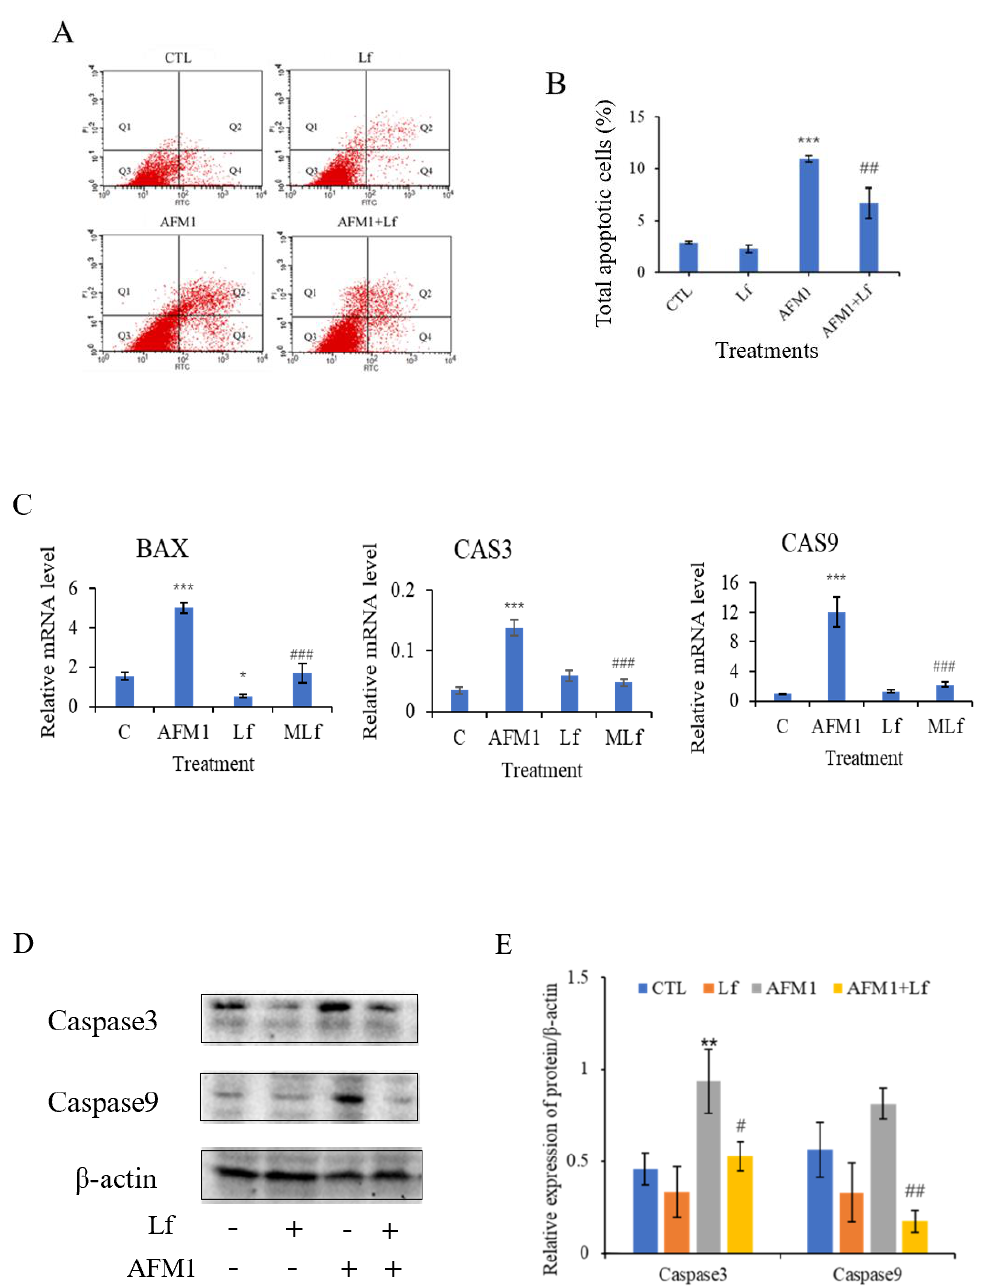
Figure 2. Lf ameliorated AFM1-induced apoptosis in NCM460 cells. The apoptosis rate of cells exposed to 8 µ g/mL AFM1 with or without Lf of 100 µ g/mL. ( A ) Flow cytometry plots of NCM460 cells. ( B ) The sum of the early and late apoptotic cell populations was the total apoptotic cells. ( C ) Relative mRNA levels of apoptosis genes. C represents control, MLf represents combined AFM1 and Lf. ( D , E ) Immunoblotting was performed on protein extracts for autophagy proteins and band densities quantification. Results represented as means ± SD. * p < 0.05, ** p < 0.01, *** p < 0.001 vs. control (C/CTL). # p < 0.05, ## p < 0.01, ### p < 0.001 vs.